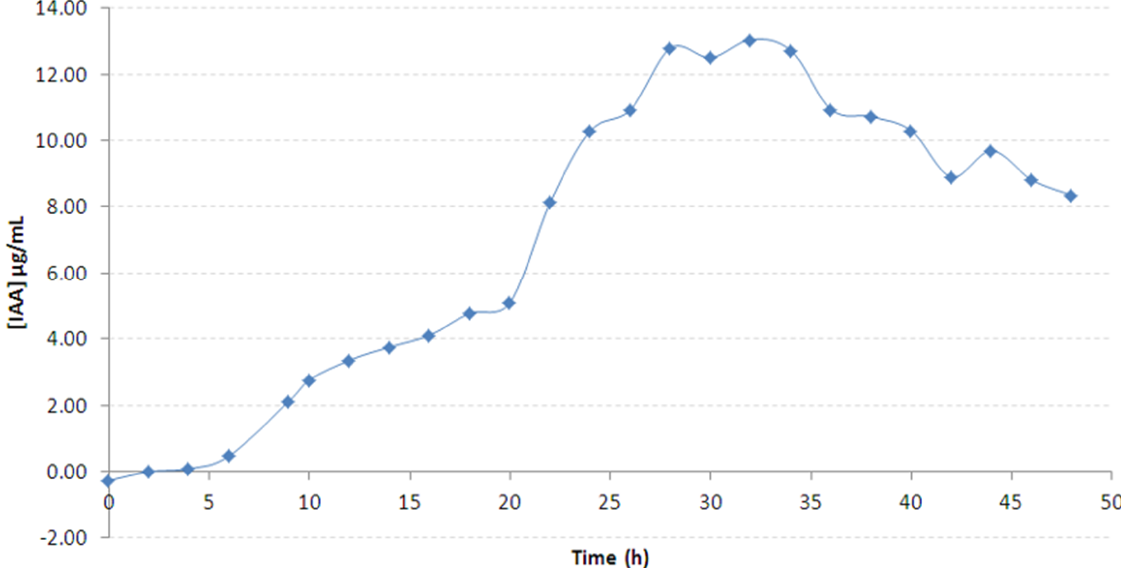
Figure 6. Production of auxins-type phytohormones (equivalent IAA) by Bacillus velezensis B25, during 48 h in TSB+L-Trp